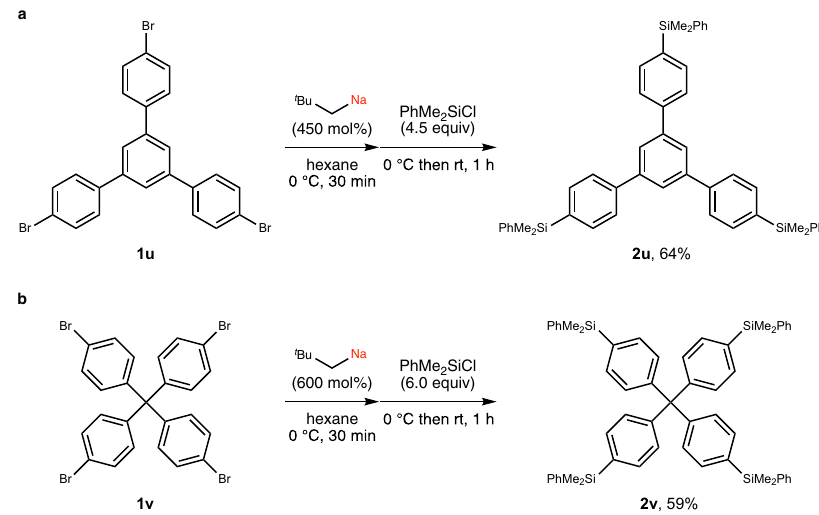
Fig. 4 Multisodiation through bromine – sodium exchange. a Triple sodiation of 1u : neopentylsodium prepared in situ from neopentyl chloride (450 mol%) and SD (950 mol%) in hexane (3.0 mL) at 0 °C for 20 min was reacted with 1,3,5-tris(4-bromophenyl)benzene ( 1u , 0.25 mmol, 1.0 equiv) at 0 °C for 30 min, followed by addition of PhMe 2 SiCl (4.5 equiv). b Quadruple sodiation of 1v : neopentyl chloride (600 mol%), SD (1260 mol%), tetrakis(4- bromophenyl)methane ( 1v , 0.20 mmol, 1.0 equiv), and PhMe 2 SiCl (6.0 equiv). Yields determined by isolation are shown. SD sodium dispersion, t Bu tert - butyl, Ph phenyl, Me methyl.